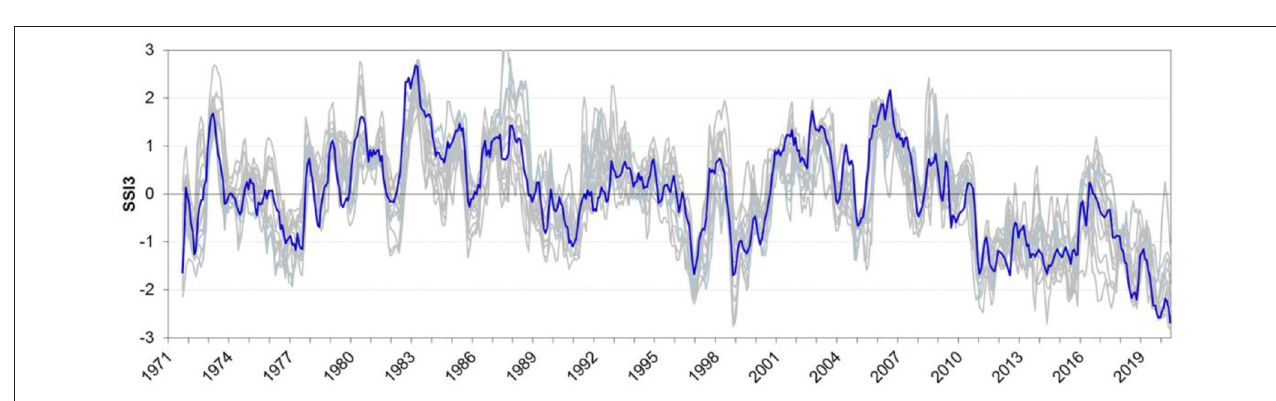
FIGURE 7 | Time series of monthly SSI3 for the selected gauging stations during 1971/72-2019/20. The blue line indicates the time series for the Atuel River